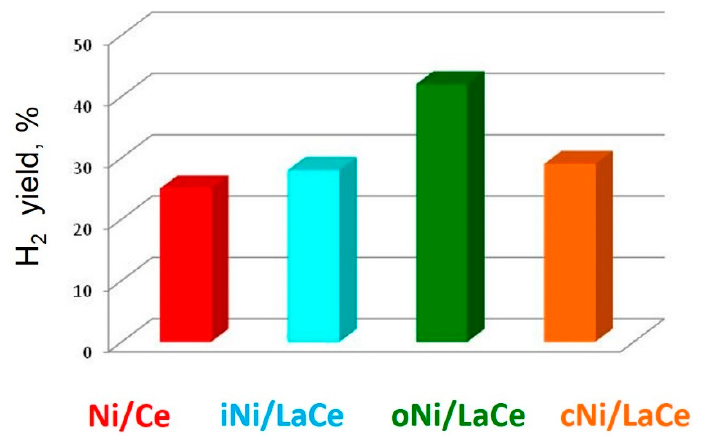
Figure 4. H 2 yield of the different samples after 18 h of reaction at 550 °C.